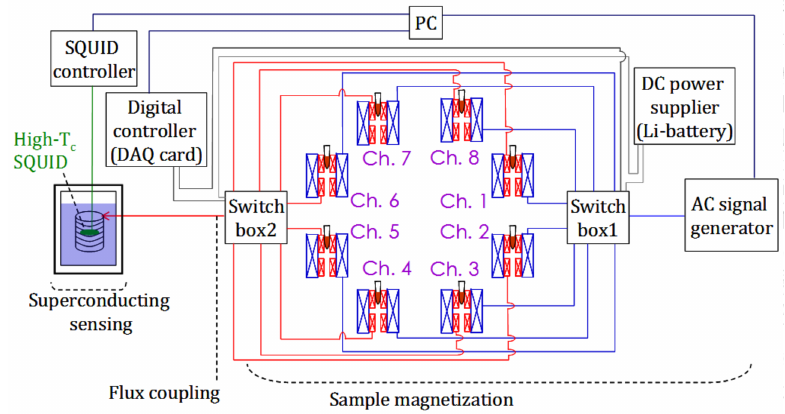
Figure 1. Configuration of the eight-channel ac magnetosusceptometer for MNPs.